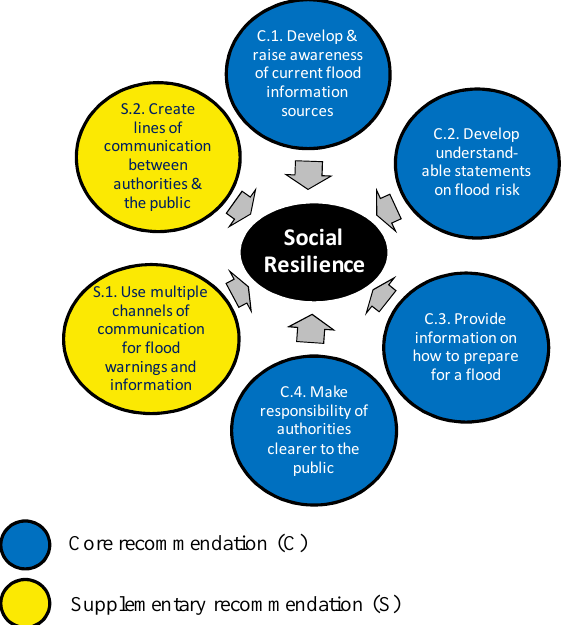
Fig. 10. Social resilience framework for improving flood risk com- munications, with rank order as defined by respondents and with Figure 10. Social resilience framework for improving flood risk communications, with rank3 core and supplementary status according to their relationship with order as defined by respondents and with core and supplementary status according to their4 relationship with resiliency5